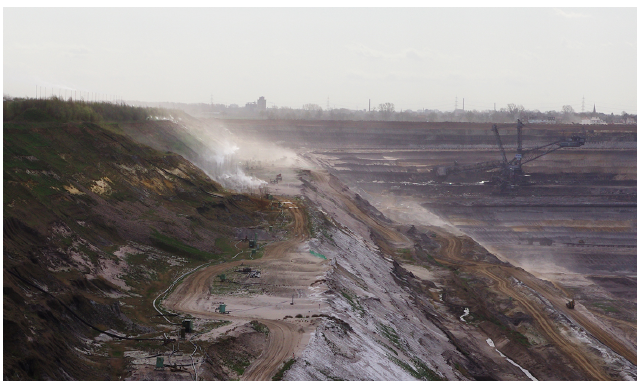
Figure 13. Photograph of the easterly border of the open-pit mine of Inden on 18 April 2013. Strong dust emissions were observed. The LACROS site was located 1.5km east (i.e. downwind) of the